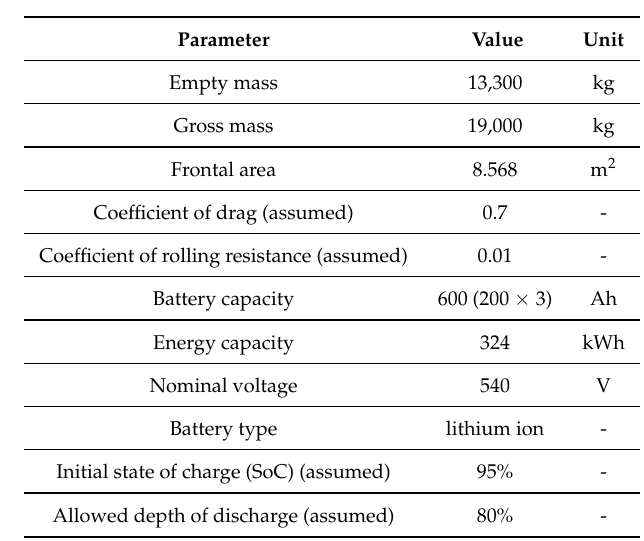
Table 1. Reference parameters for simulating the dynamical consumption model of the electric vehicle